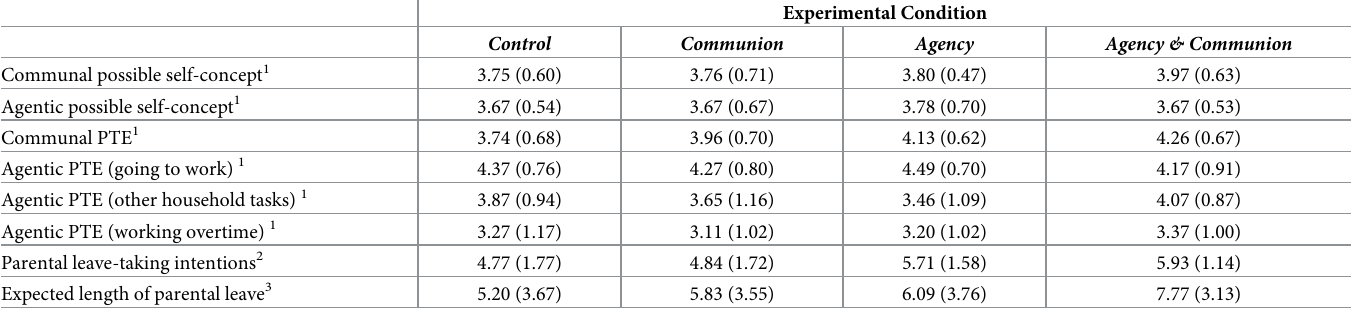
Table 3. Means and standard deviations for possible selves and parental leave outcomes in experimental conditions (Experiment